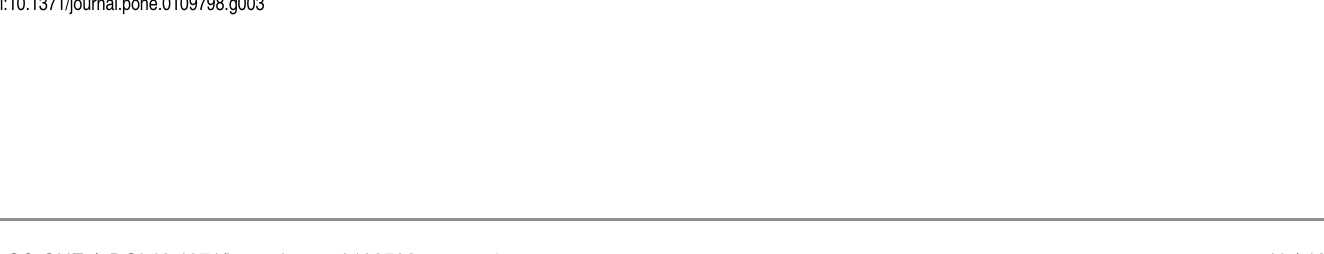
Fig. 3. Taxa of differential abundance between the control and CF lower airway. Circular Phylogenetic Tree was rendered in iToL and illustrates abundance changes between eOTUs present in the control lower (inner ring) and CF lower (outer ring) airways. The colour saturation indicates the degree of difference from the mean control lower value for the eOTU; where dark blue indicates a HybScore difference of 2 52326, white 5 0 (no change from mean control lower), dark red 5 + 61480. Two eOTUs remained of significantly differential abundance following Benjamini-Hochberg correction; Prevotella veroralis (*) and a CW040 (**). Following a permutation test, 62 taxa were found to be of significantly differential abundance, Corynebacterium (***) is highlighted. A detailed list of the 59 taxa of significantly differential abundance between categories is provided in the supplementary data (S2 File).